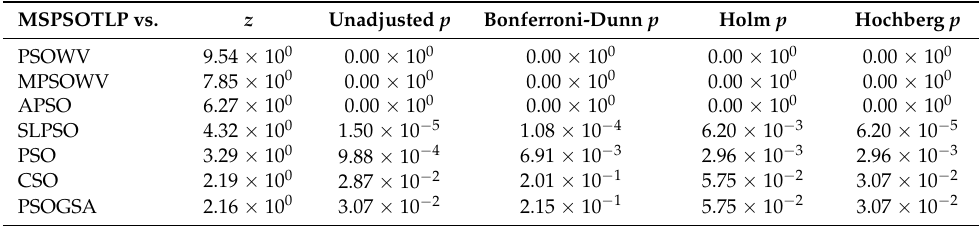
Table 8. Adjusted p values produced by each algorithm through three post-hoc analysis procedures. MSPSOTLP